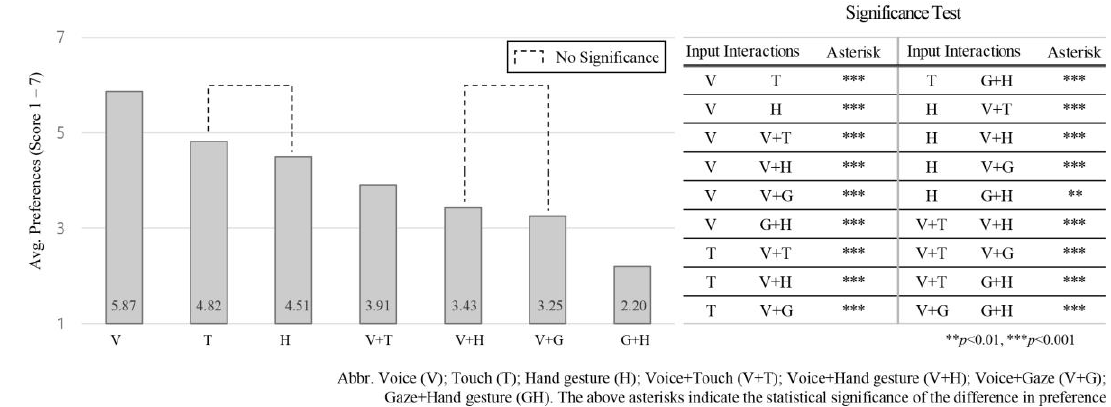
Figure 4. Average preference for seven input interactions according to the “ranking data” across all intervention scenarios and NDRT